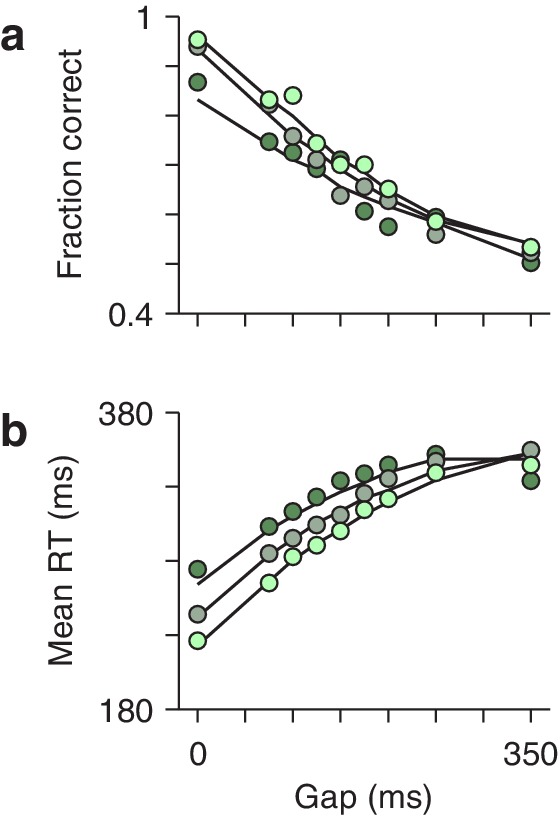
The race-to-threshold model reproduces average performance in individual gap conditions.(a) Mean fraction of correct choices as a function of gap. Circles are experimental results for high (bright green), medium (grayish green), and low luminance (dark green) conditions; continuous lines are model results. (b) Mean RT as a function of gap. Same conventions as above. All experimental points represent data pooled across participants.